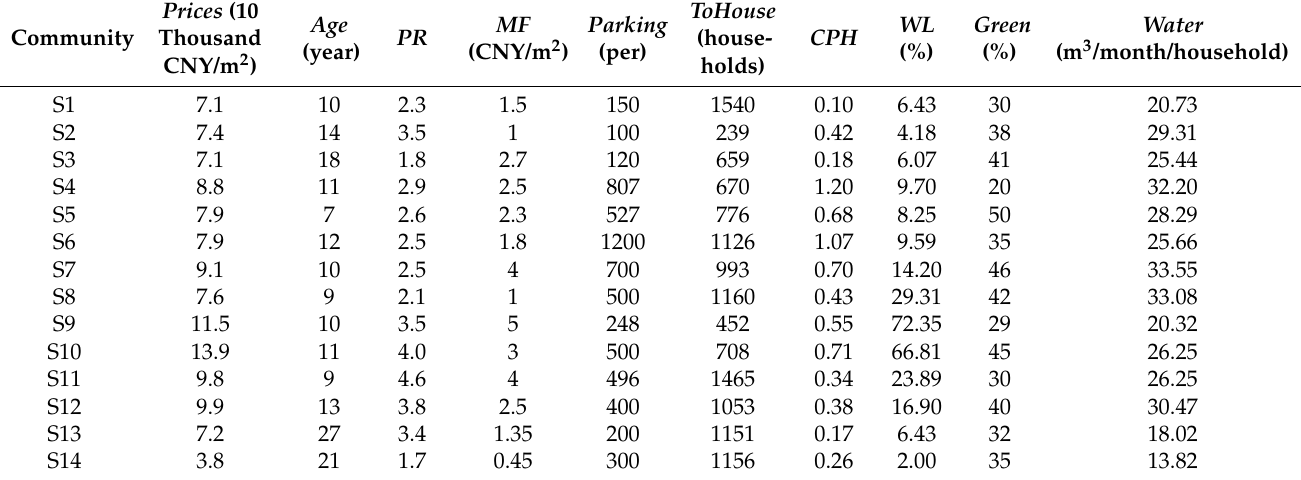
communities. In contrast, the houses in the S13 and S14 communities are old, with low Table 2. The parameters of the 14 investigated communities in 2017. housing prices, low MF , and low WL , which are traits of typical low-end communities. Table 2. The parameters of the 14 investigated communities in 2017.